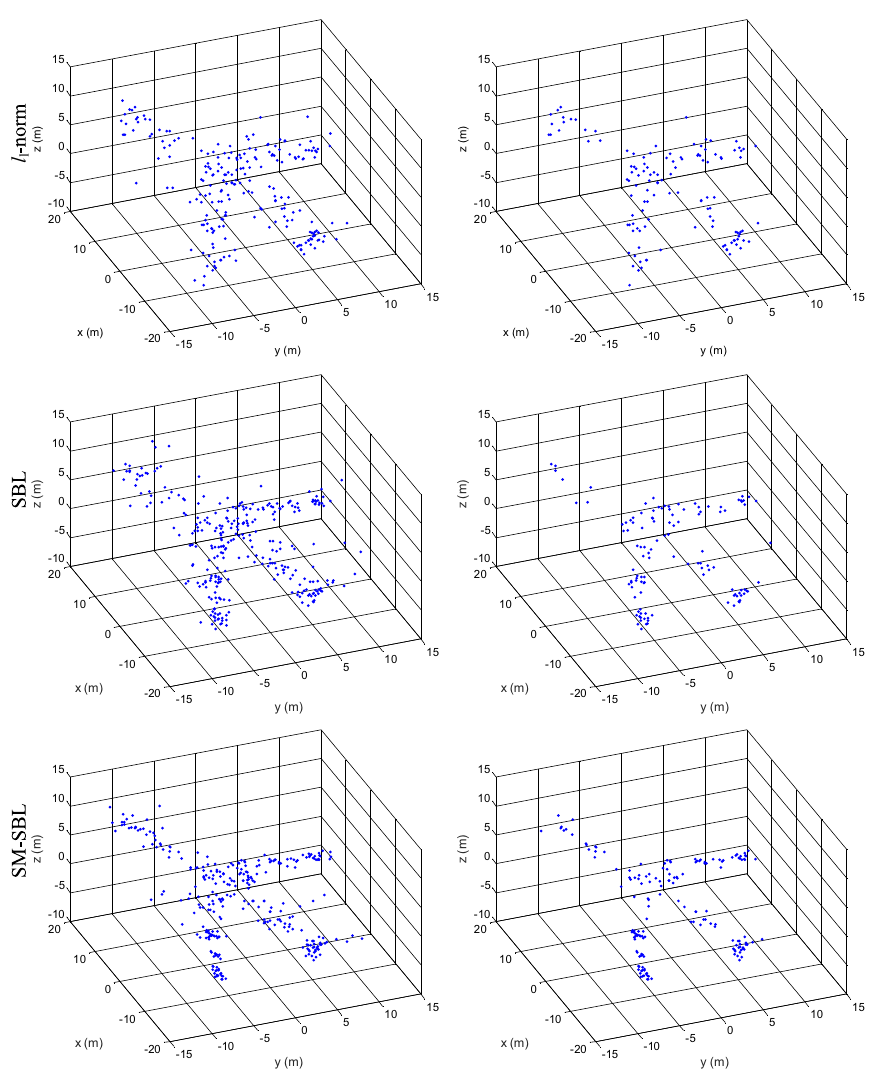
Figure 9. Reconstructed 3-dimensional (3-D) scatterer distributions for random missing sampling